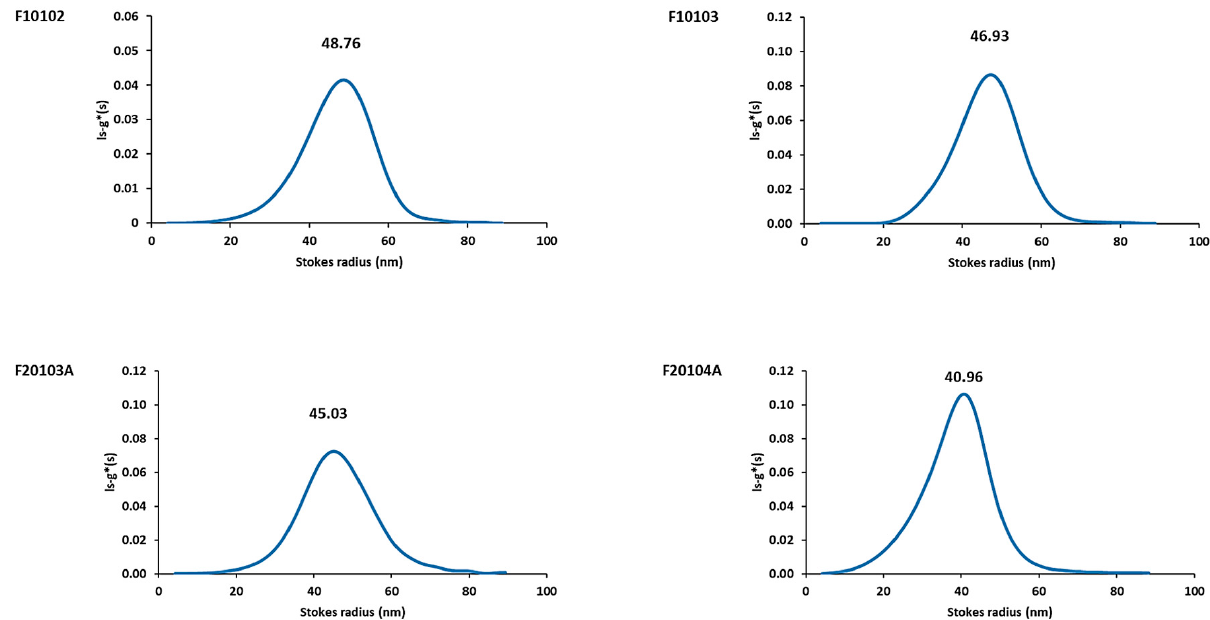
Figure 4. AUC measurement results of liposome size distributions. Stock liposomes were diluted in PBS to a final concentration of 50 µg/mL before proceeding with AUC measurements. PBS was used as control in the reference cell. ls-g*(s) sedimentation coefficient distributions of selected liposomes were calculated from AUC measurements using interference optics and transformed to size distributions. A representative measurement for each of the selected liposomes is reported, with the Stokes radius value expressed in nm.